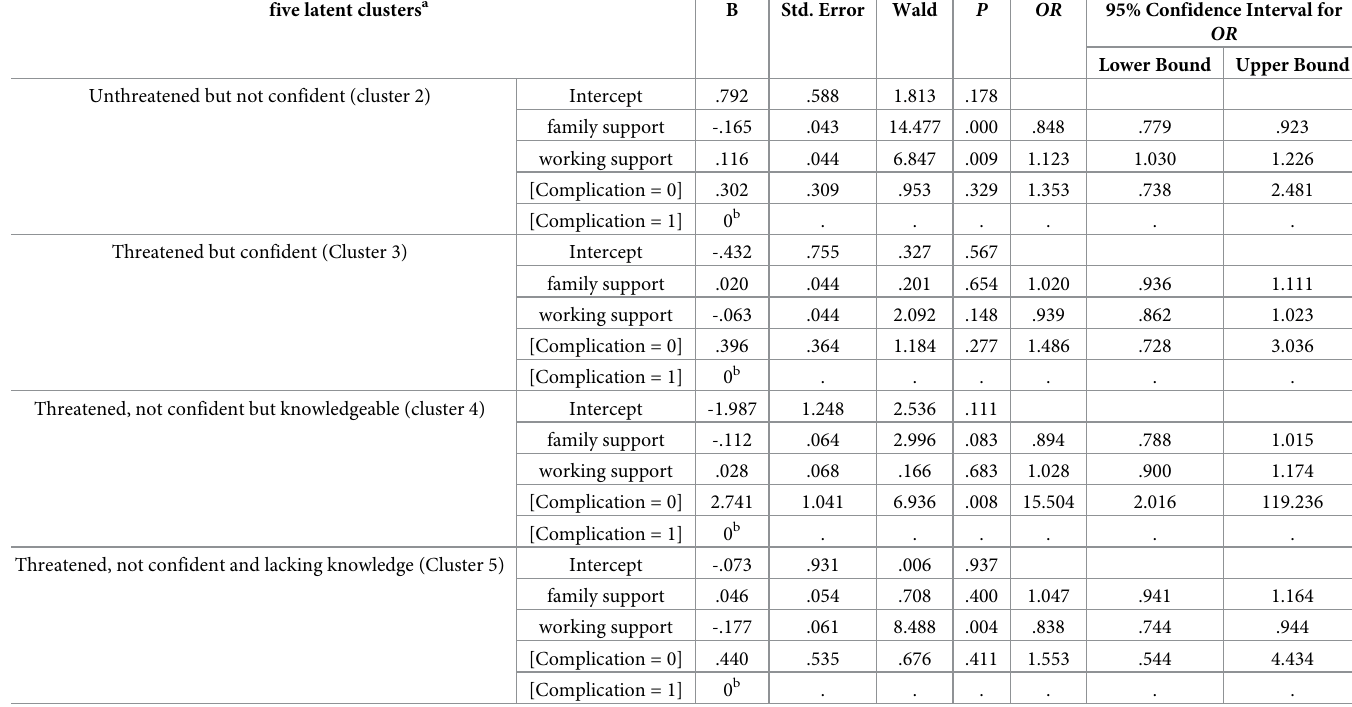
OR Lower Bound Upper